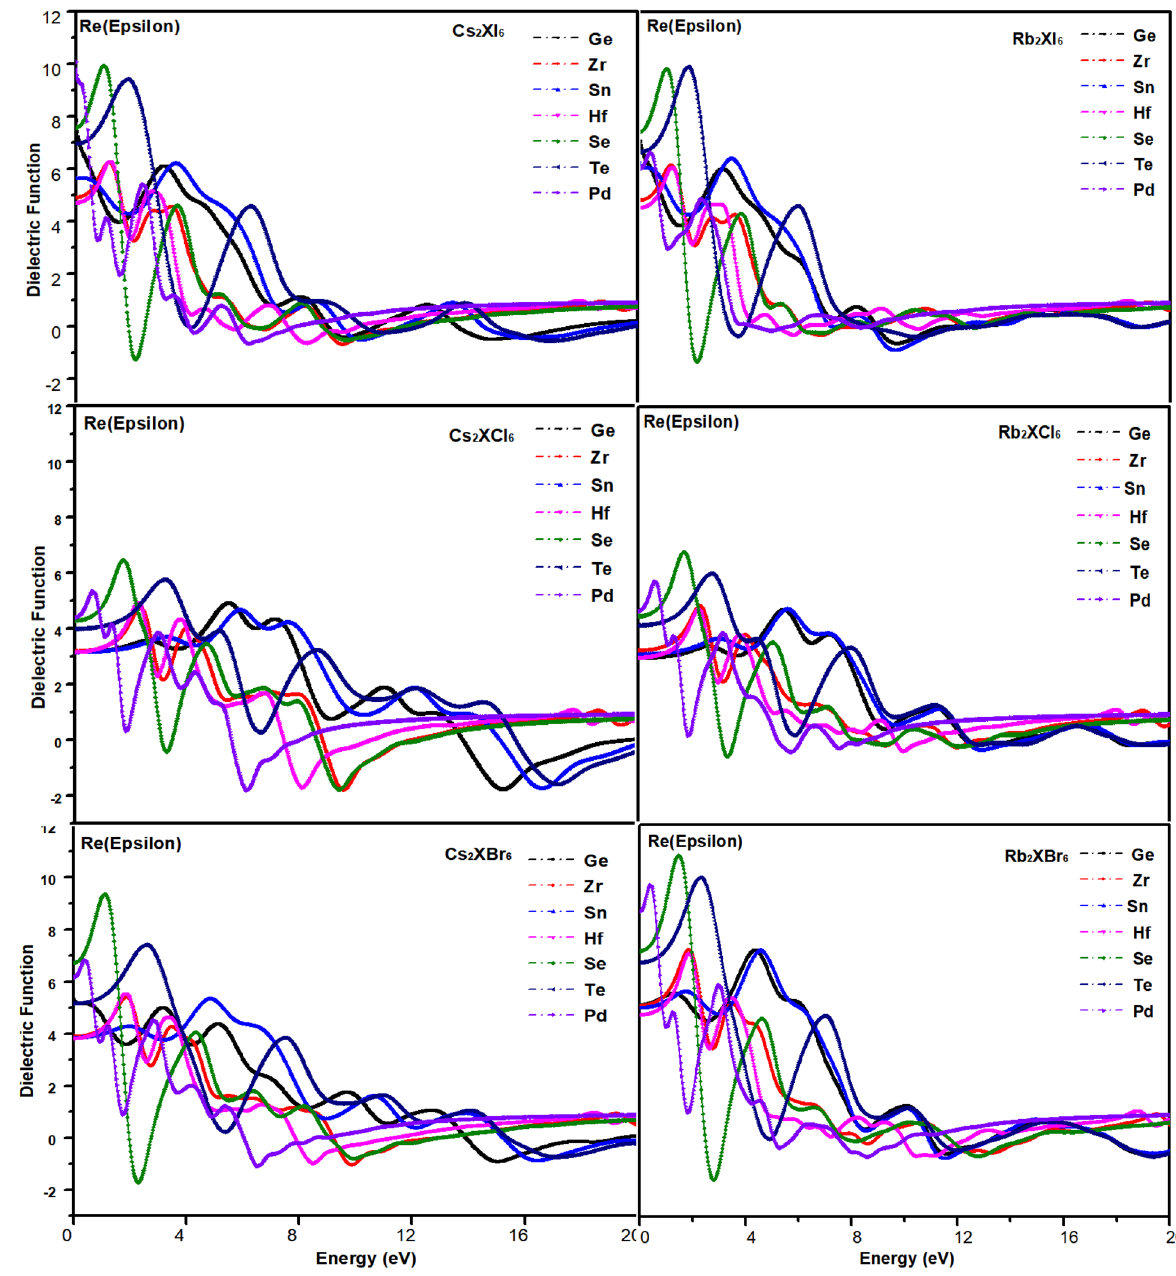
Figure 8. Real part characteristic curve of